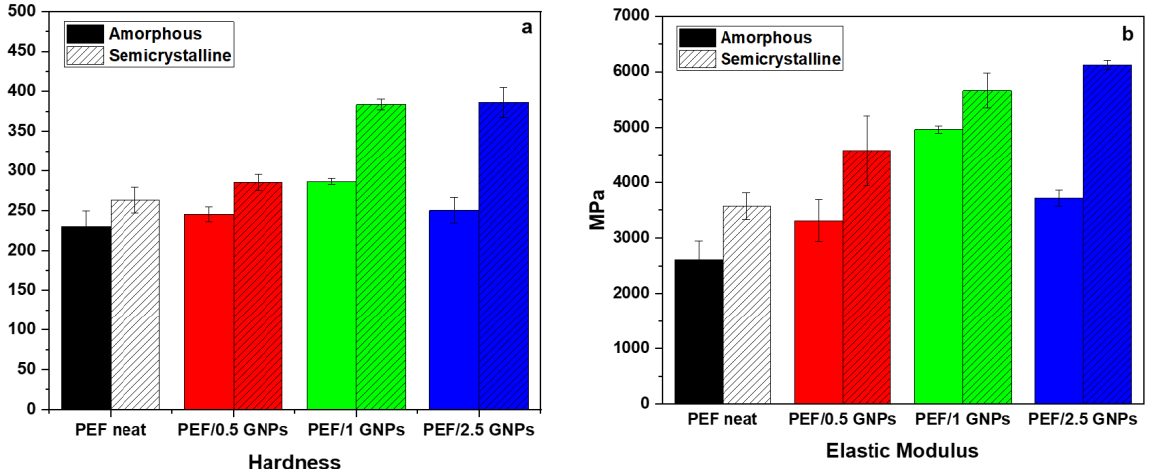
Figure 11. Comparison of ( a ) the hardness and ( b ) elastic modulus of the amorphous and semicrys- talline neat PEF and PEF/GNP nanocomposites.